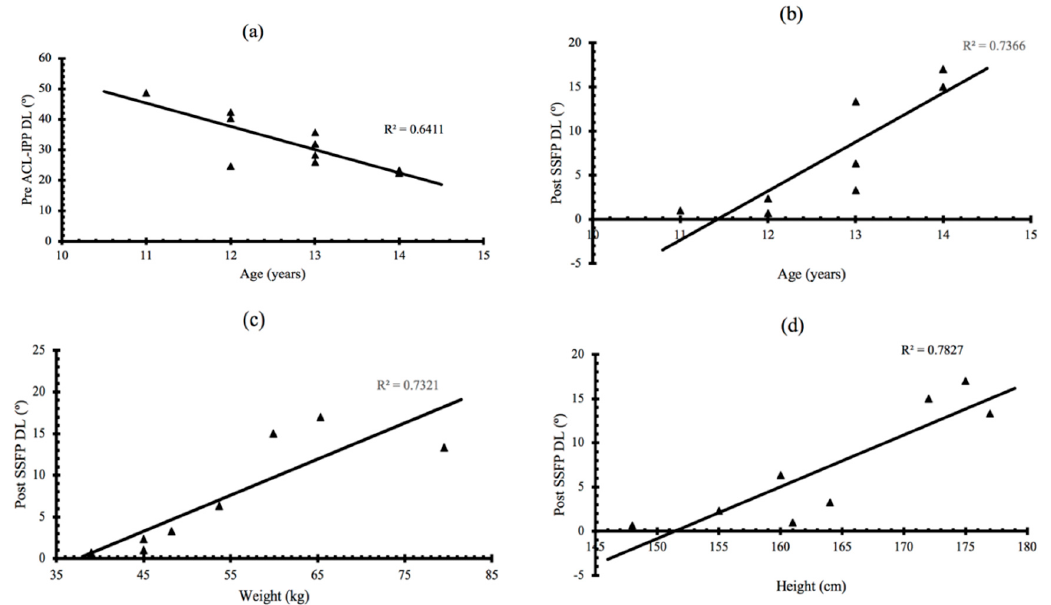
Figure 3. Significant correlations found between: ( a ) pre-ACL-IPP DL and age; ( b ) post-SSFP DL and age; ( c ) post-SSFP DL and weight; ( d ) post-SSFP DL and height. ACL-IPP—ACL injury prevention protocol; SSFP—soccer-specific fatigue protocol; DL—dominant leg.